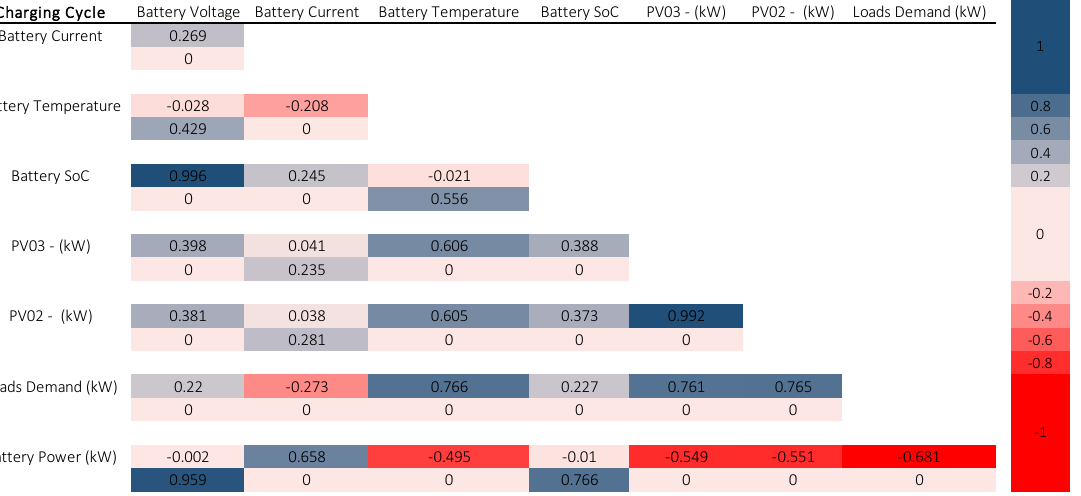
Figure 17. Spearman correlation matrix in charging cycle of storage system.